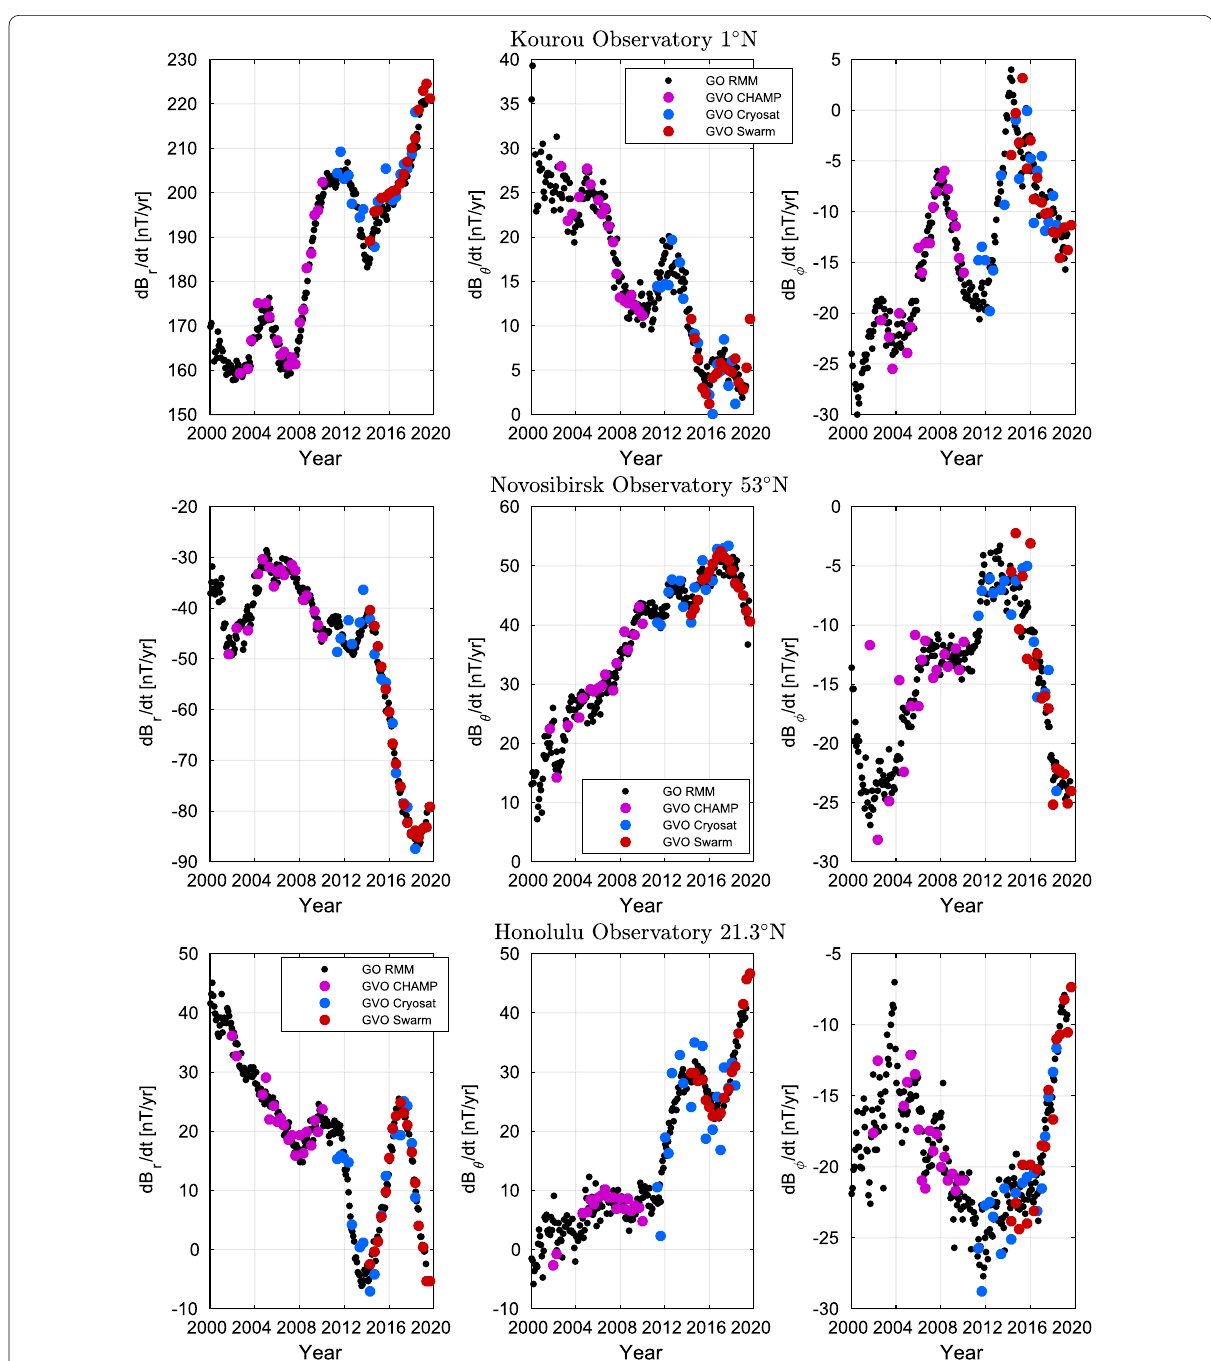
Fig. 4 SV times series obtained from annual differences of revised monthly means (black dots) (Olsen et al. 2014), and 4-monthly Core Field GVOs derived from CHAMP (purple dots), CryoSat-2 (blue dots) and Swarm (red dots) data. Note the GVO estimates have been mapped from satellite altitude to ground in order to aid the